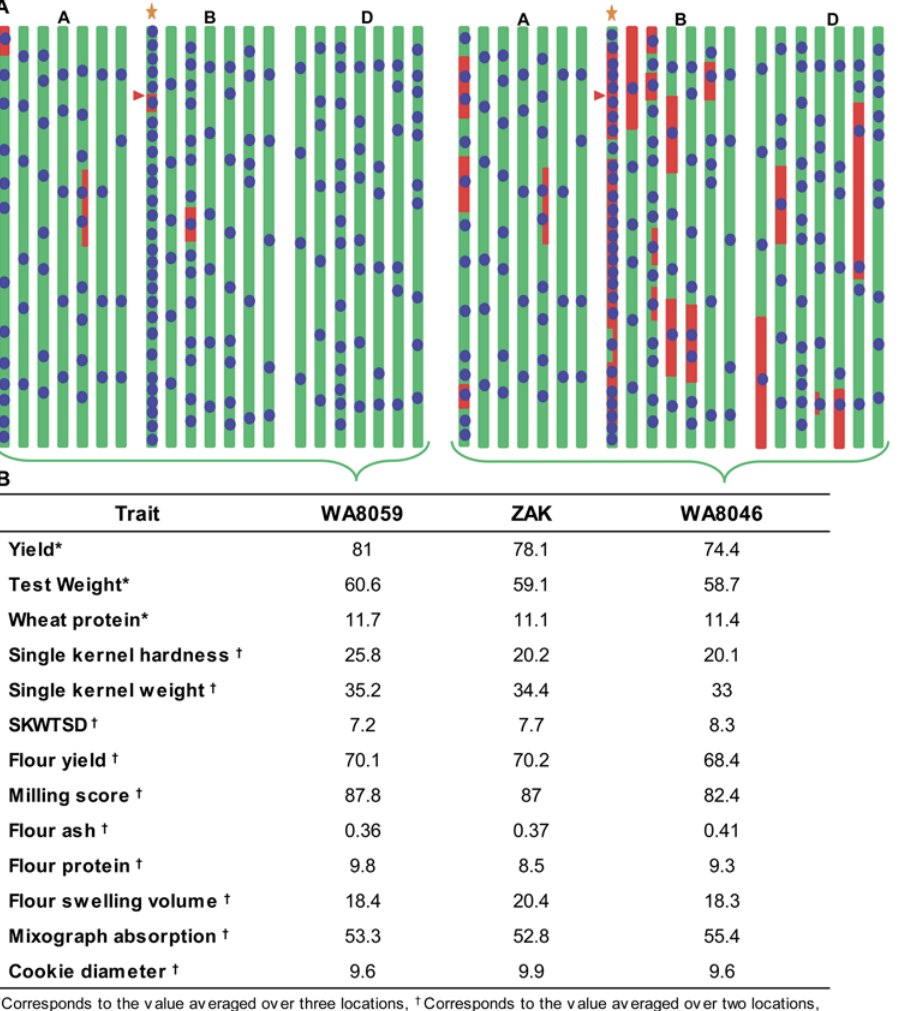
Figure 3. Comparison of cultivar ‘Zak’ derivatives carrying stripe rust resistance gene Yr15 developed with (WA8059) and without (WA8046) MABS. (A) Graphical genotypes, showing parental derivation with green bars representing the homozygous RP alleles, red bars indicate the marker allele homozygous for DP, and heterozygous loci were marked with half green and half red bars. Orange star represents the carrier chromosome, with red arrow corresponding to the approximate position of the target gene ( Yr15 ) on the carrier chromosome and blue dots denotes relative position of the SSR markers used for the comparison. (B) Comparison of various parameters recorded during field evaluation and quality analysis of these three lines done at different locations.